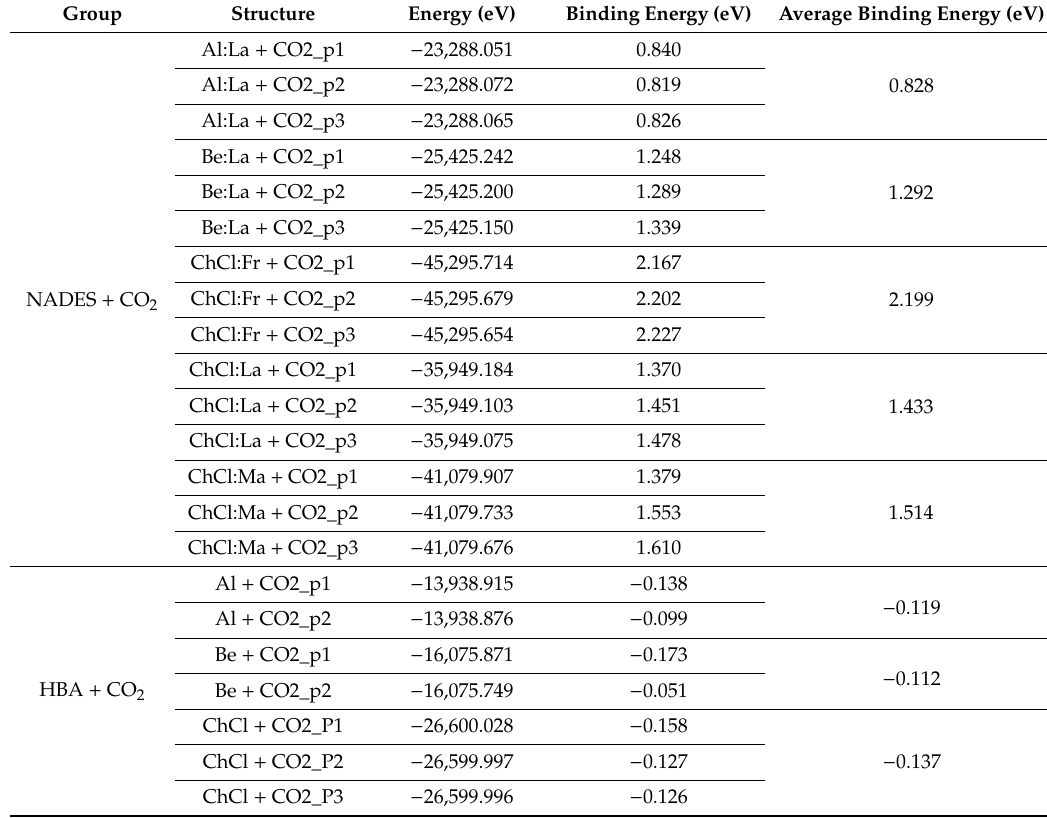
Table 4. Optimized energies of HBA, HBD, and natural deep eutectic solvents (NADES) interacting with CO 2 at various spatial